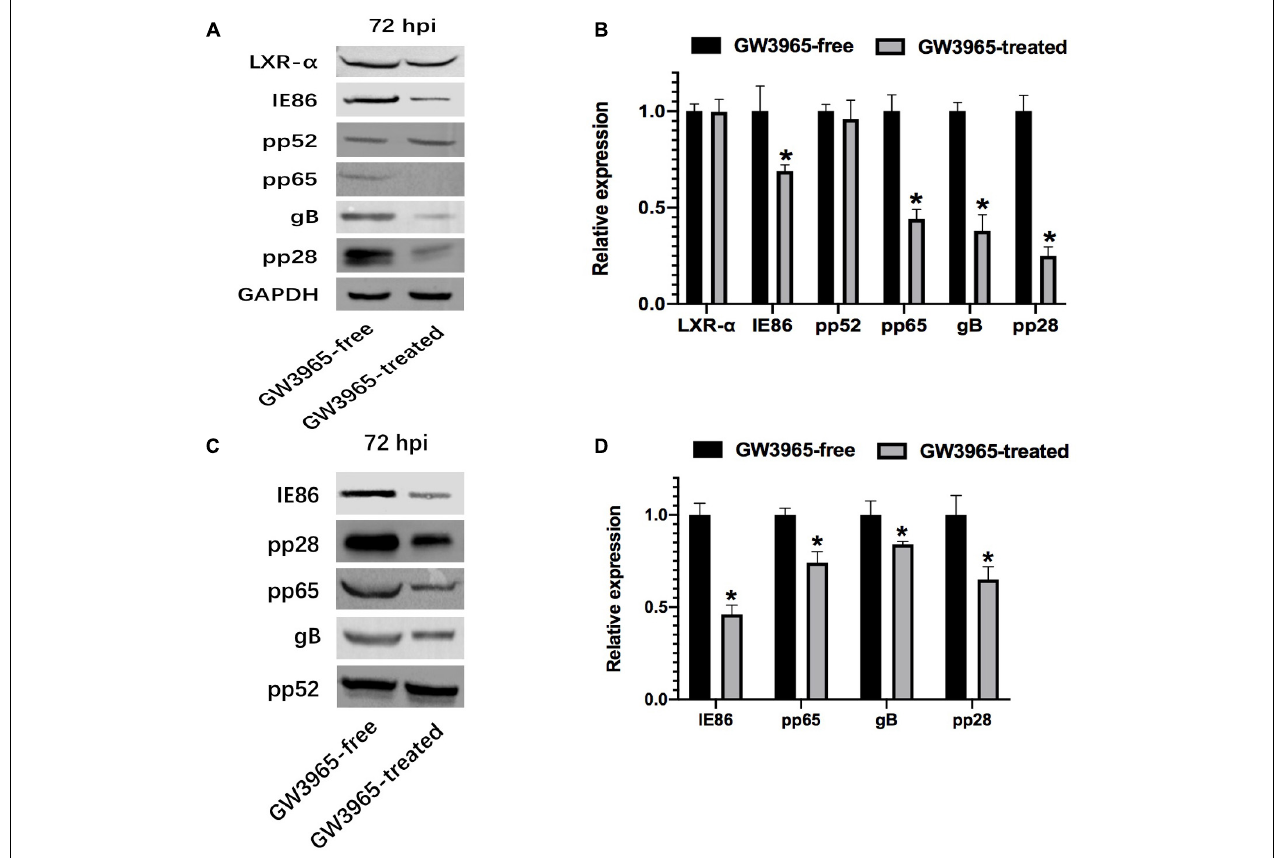
FIGURE 1 | Effect of activated LXR on the expression of important protein. (A) Expression of important viral proteins was detected by Western blot in HCMV-infected HFFs. The cells were infected with HCMV Towne strain and treated with or without GW3965 for 72 h. GAPDH was used as a loading control of total proteins. LXR, IE, gB, pp65, pp28, and pp52 were detected. (B) The bands from three repeated experiments were scanned, the density of bands was quantified and the gray values of the two groups were compared. The ratios of gray values from each sample are used to conduct statistical analysis, P < 0.05 ( n =